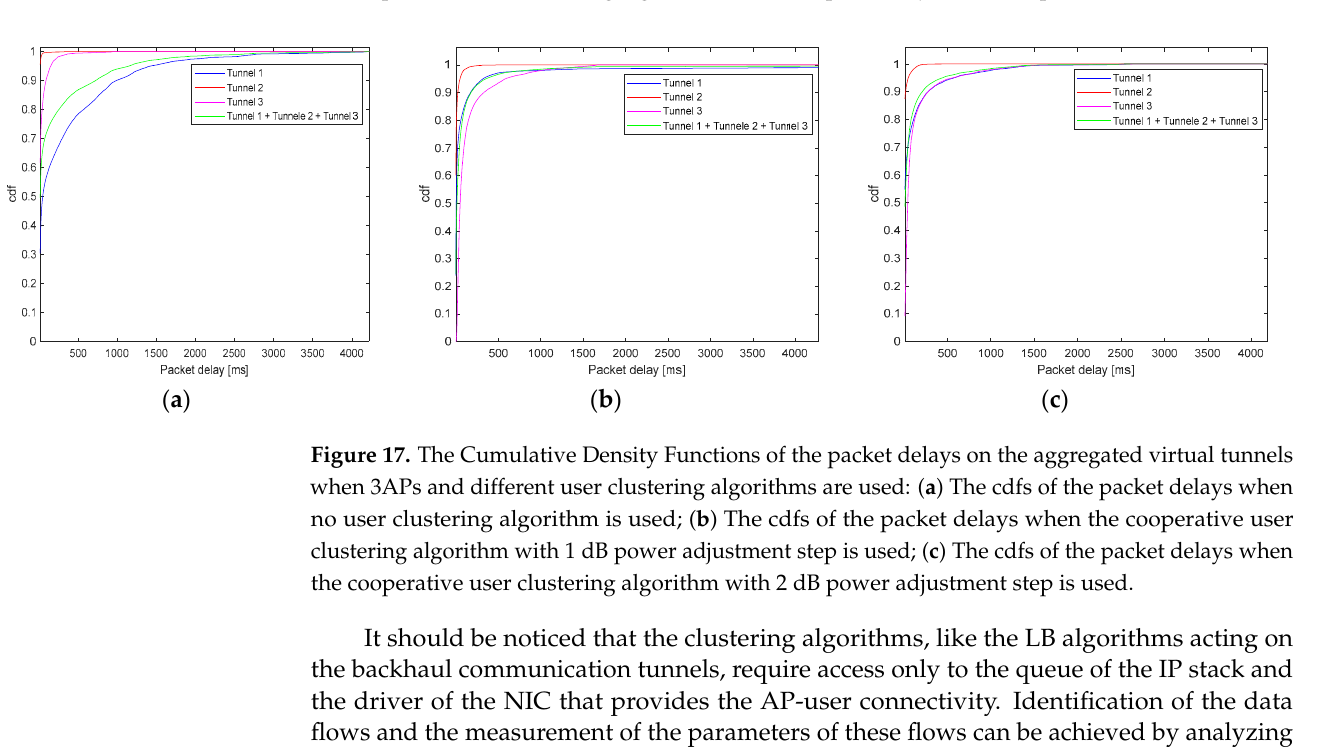
Figure 16. Statistical characterization of the packet delays on the aggregated virtual tunnels when 3 APs and different user clustering algorithms are used: ( a ) The pdfs of the packet delays when no user clustering algorithm is used; ( b ) The pdfs of the packet delays when the cooperative user clustering algorithm with 1 dB power adjustment step is used; ( c ) The pdfs of the packet delays when the cooperative user clustering algorithm with 2 dB power adjustment step is used.